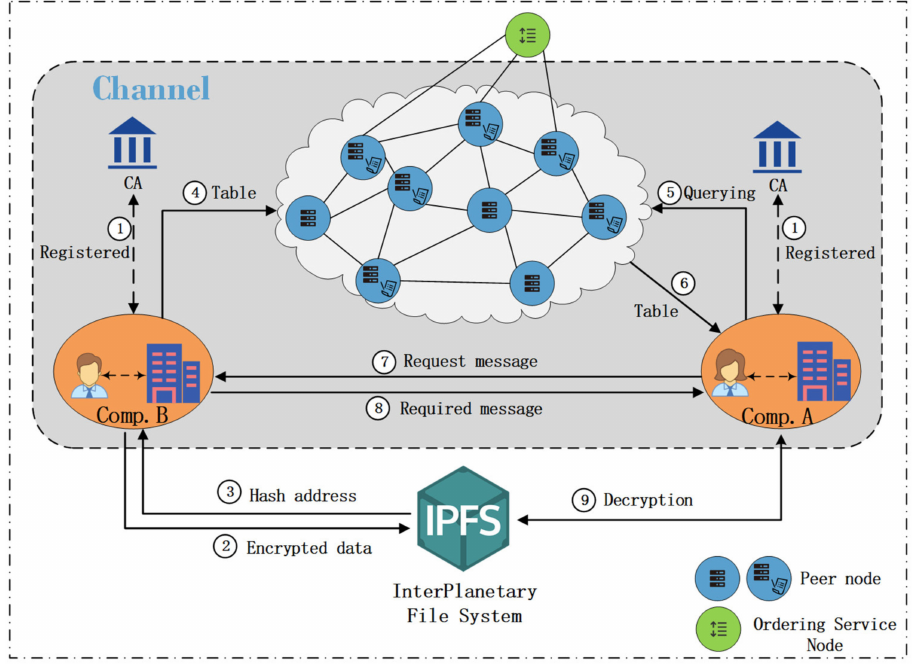
Figure 3. Enterprise data sharing process within